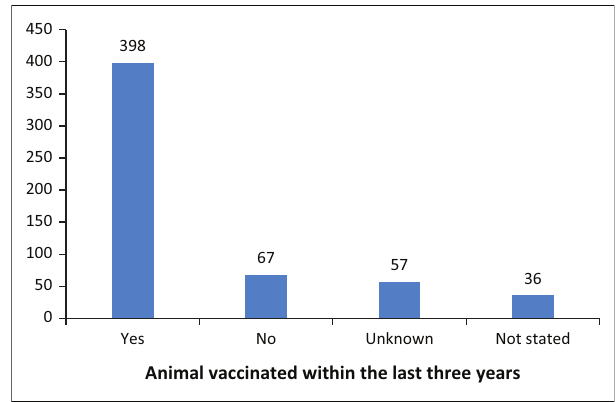
FIGURE 3: Completeness of vaccination for animals known to be